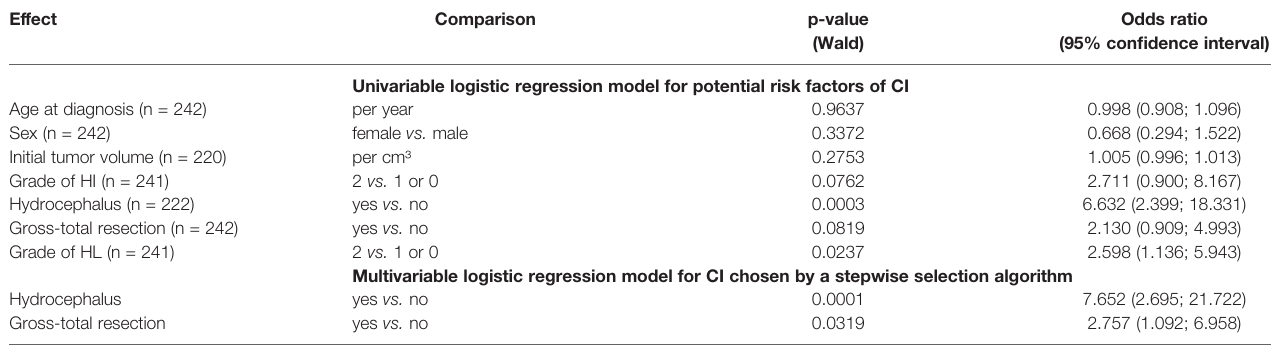
TABLE 3 | Result of univariable logistic regression for potential risk factors of cerebral infarcts (CI) and multivariable logistic regression model for CI chosen by a stepwise selection algorithm in patients with childhood-onset craniopharyngioma recruited in KRANIOPHARYNGEOM 2007 between 2007 and